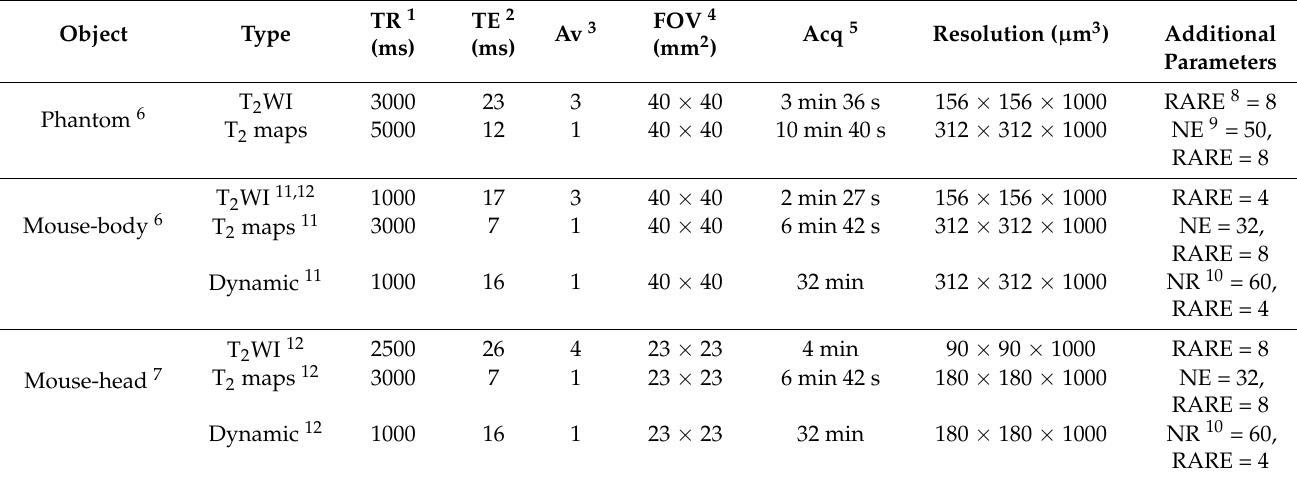
Table 1. Acquisition parameters employed in the MRI